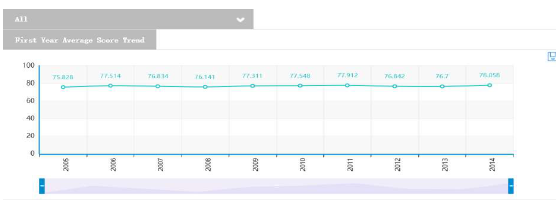
Figure 3. Book borrowing-score Correlation analysis of the times of student's book borrowing and test scores (Figure 3);